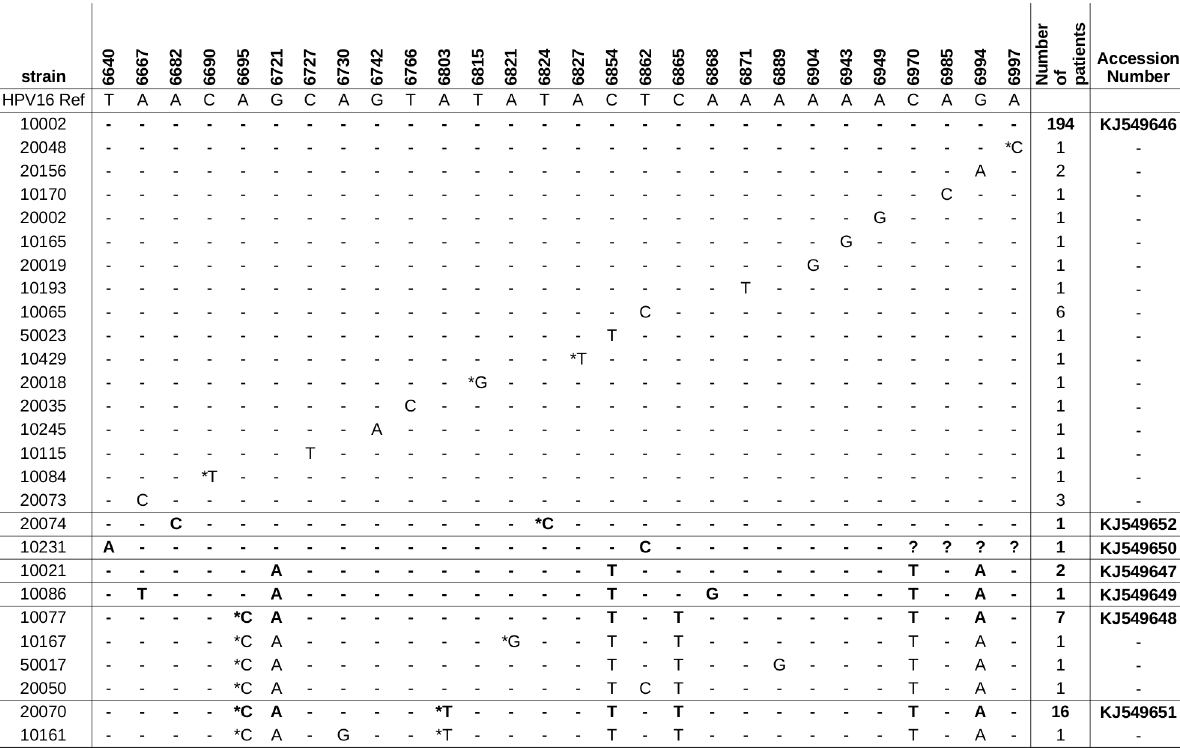
Figure 6. Nucleotide sequence variations of L1 among HPV16 isolates. Position number refers to the HPV 16 prototype sequence previously described. Asterisk indicates amino acid substitution.